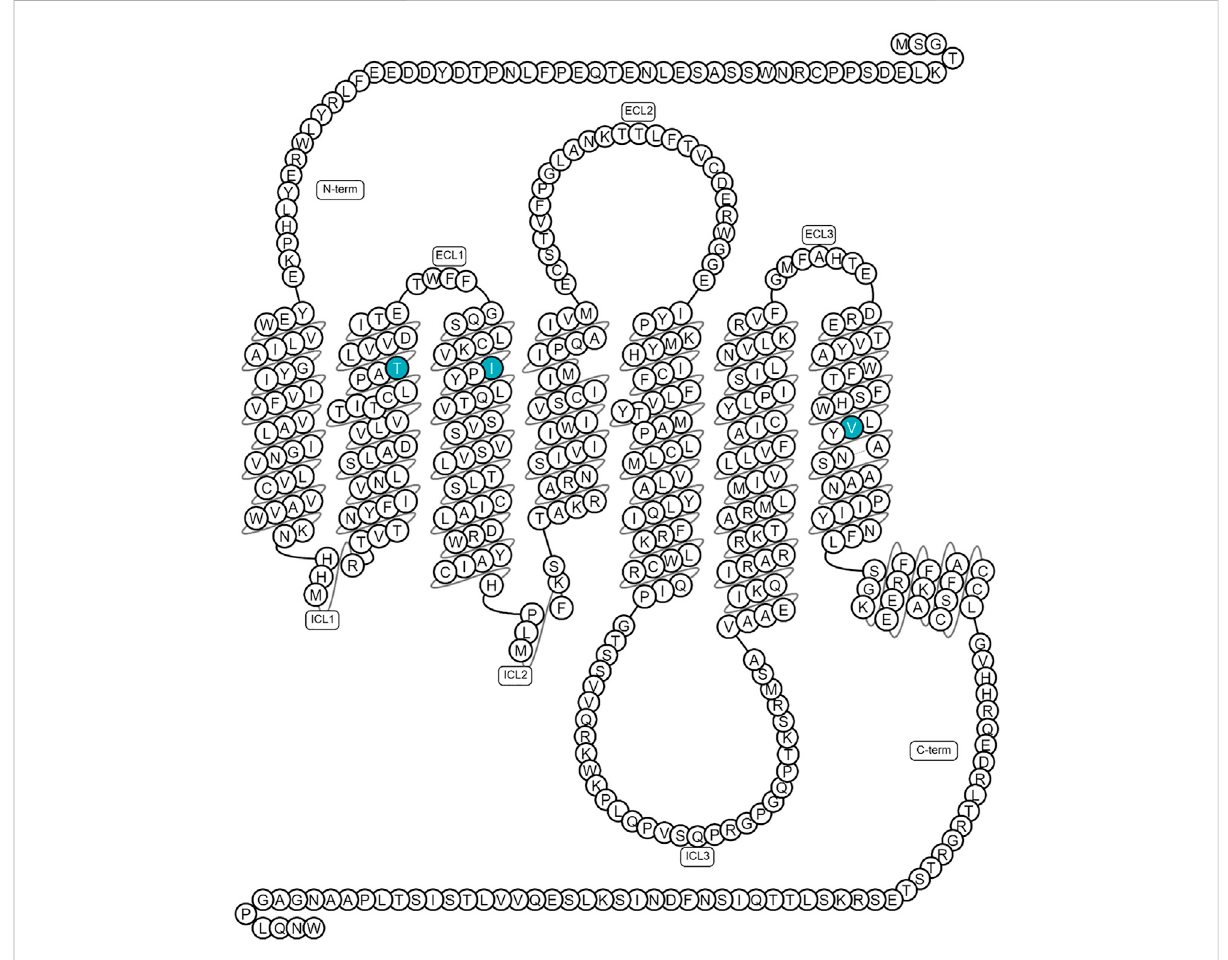
FIGURE 8 Location of the three semi-conserved binding site mutations mapped on human OX2R. Figure generated using GPCRdb